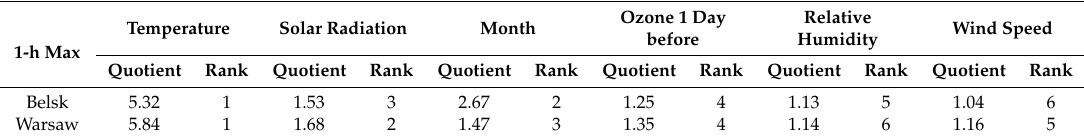
Table 2. The results of global sensitivity